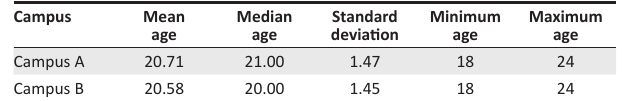
TABLE 2: The means procedure of the age of